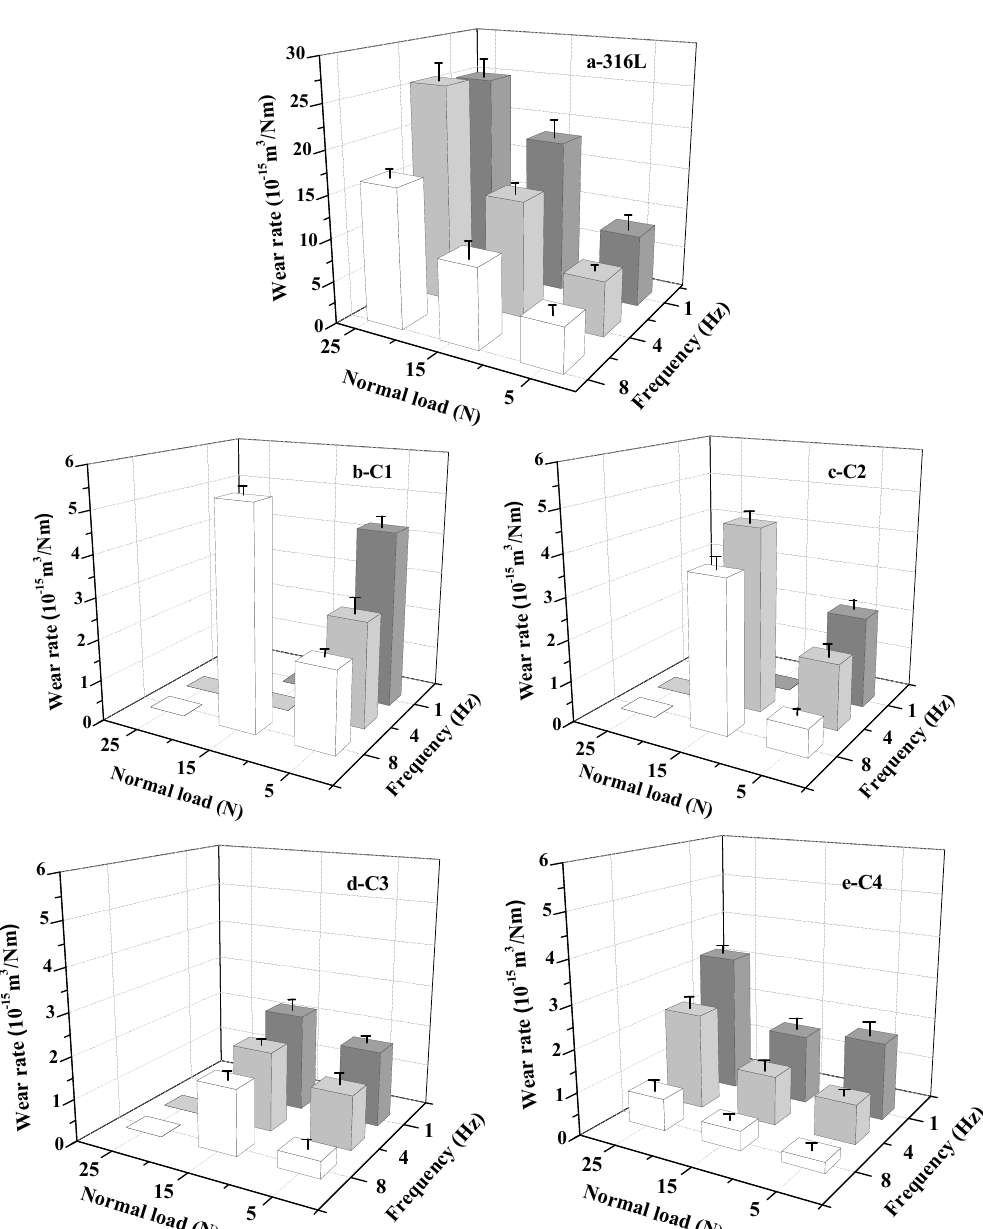
Figure 7. The COF of 316L substrate and CrN films in seawater: ( a ) 316L; ( b ) C1; ( c ) C2; ( d ) C3; ( e ) C4.